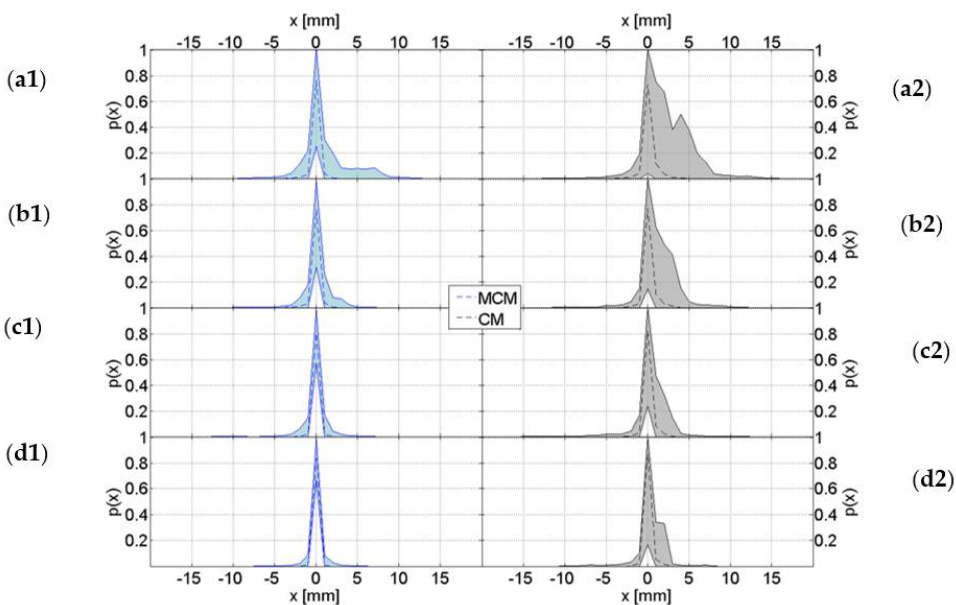
Figure 9. Ensemble of the PDF of differences between run and original field. The subplots correspond to the different sampling percentage of gauge used: ( a ) 10%, ( b ) 25%, ( c ) 50%, and ( d ) 75%, while the numbers 1 and 2 are the MCM and CM simulations, respectively.